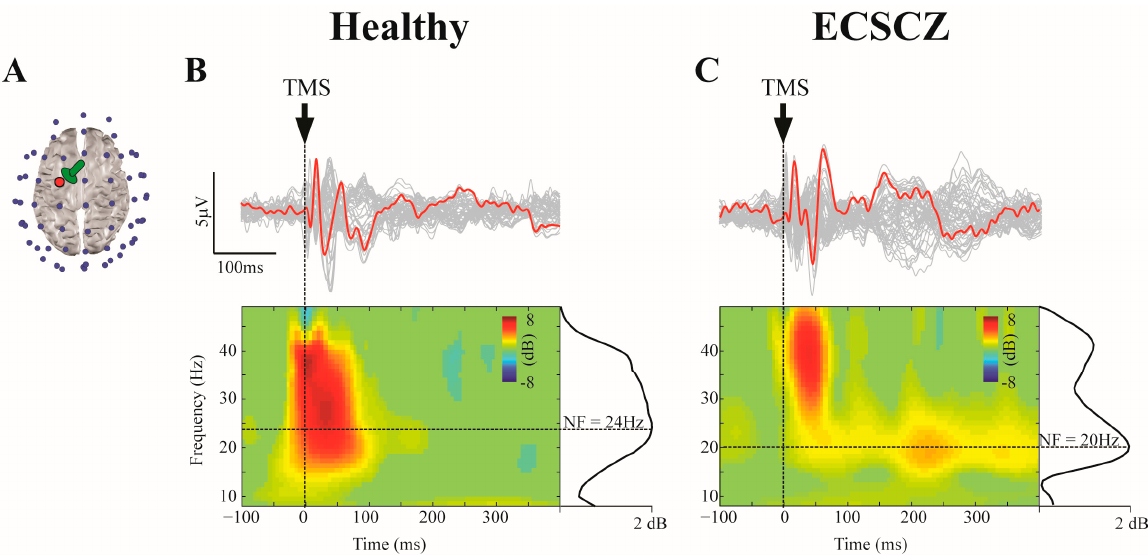
Figure 1. Single-pulse TMS of the left premotor cortex elicited EEG responses with similar time- courses, but slower natural frequencies in patients with early-course schizophrenia (ECSCZ) com- pared to HCs. Figure shows: ( A ) the position of the TMS coil (green) relative to the brain (gray) and the 64 EEG electrodes (blue dots). The red dot indicates the EEG electrode closer to the stimulation site, where the natural frequency was calculated. (( B ), top) Butterfly plots of the TMS-evoked po- tential (TEP) averaged across trials in a representative HC subject. The red trace indicates the EEG electrode closest to the stimulation site. (( B ), bottom) Event-Related Spectral Perturbation (ERSP) in the red electrode alongside the cumulate spectral power profile in the same electrode (solid black curves) and its peak frequency (or natural frequency, horizontal dotted lines). ( C ) depicts the same as in ( B ) in a representative ECSCZ patient. Vertical dotted lines under the arrows marked the time point when single-pulse TMS occurred